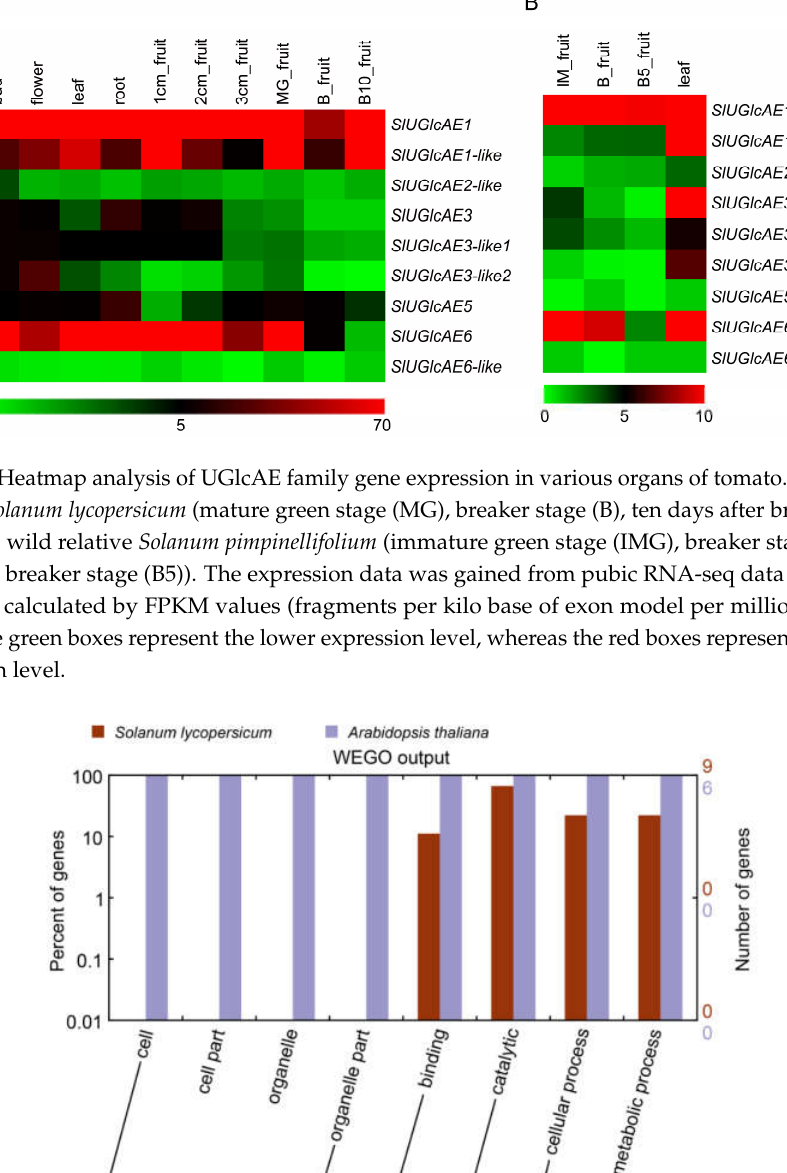
Figure 6. Assignment of Gene Ontology categories to UGlcAE genes in tomato. The lengths of the rectangular columns indicate the number of genes that participated in the corresponding classification. The purple rectangular columns mean gene functions of UGlcAE in Arabidopsis , the red rectangular columns represent gene functions of UGlcAE in tomato. All of the gene functions were classified into three categories, which were further divided into eight minor terms.